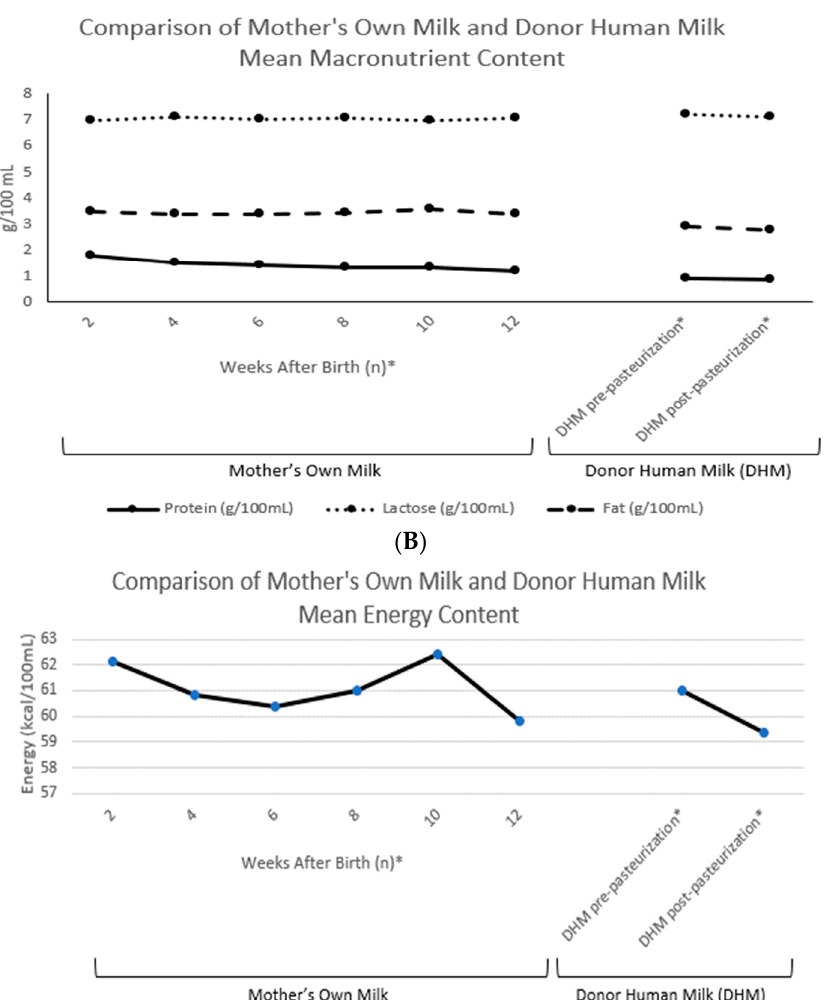
Figure 1. ( A ) Comparison of mother’s own milk and donor human milk mean macronutrient content (protein, lactose and fat; g/100 mL). ( B ) Comparison of mother’s own milk and donor human milk mean energy content. Means extracted from Piemontese et al. and Zachariassen et al. The values presented represent native (unfortified) human milk [37,41]. * Values representing the weeks after delivery are indicative of the mother’s own milk averages, whereas the donor human milk (DHM) averages represent over 90% of donor milk mothers who delivered after 37 weeks’ gestation. Donation began 2.9 ± 2.3 months after delivery